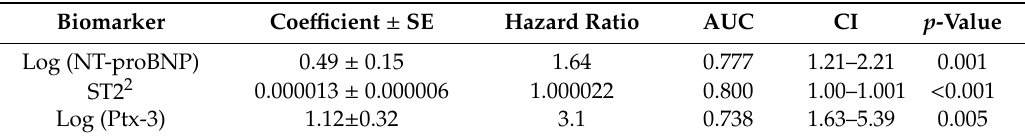
Table 6. Univariate Cox regression for biomarkers and the incidence of CV mortality after